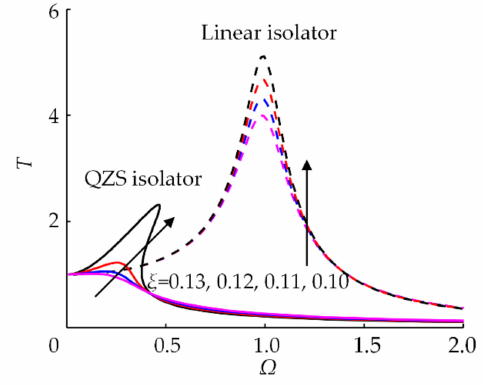
Figure 12. E ff ects of damping ratio ξ on displacement transmissibility T .